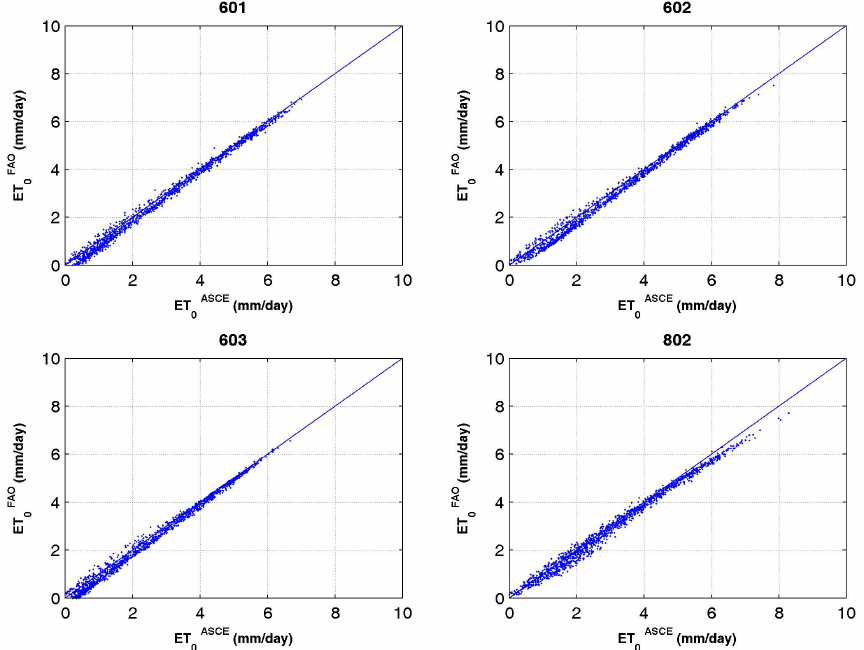
Fig. 3. ET ASCE vs. ET FAO at the four selected weather stations with hourly data (601, 602, 603 and 802) for the evaluation period (20 Novem- 0 0 ber 2004–31 August 2008).